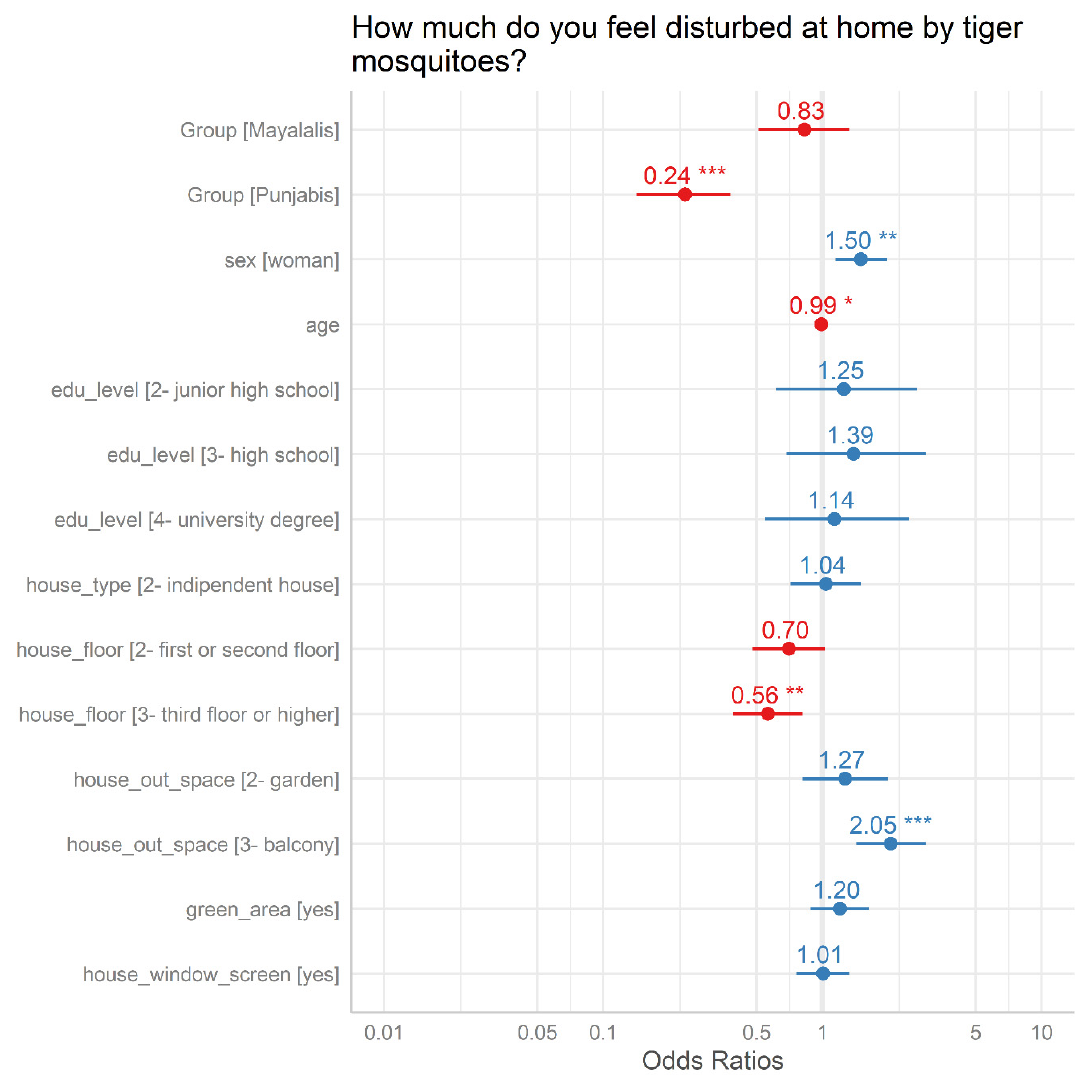
Figure 3. Estimates of the logistic regression model analyzing attitudes towards perceived mosquito nuisance at home. The points represent the average ORs (horizontal line: 95% confidence interval) of KAP.